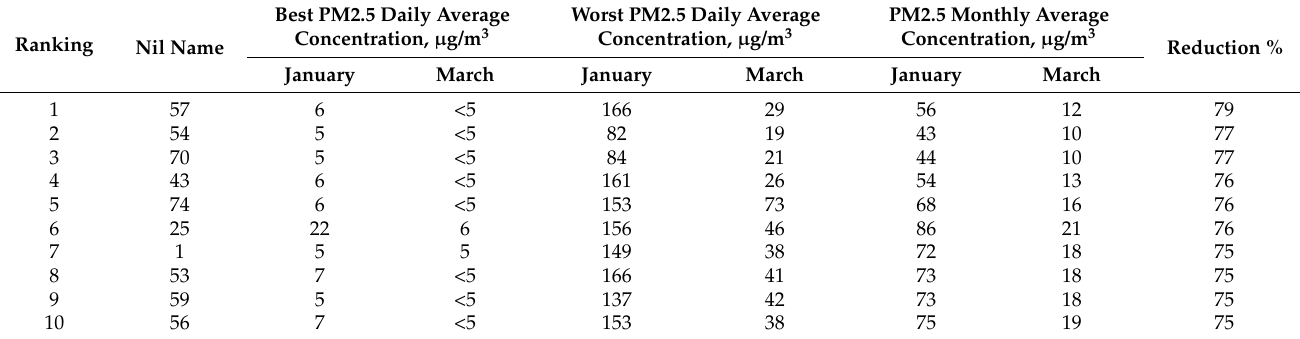
Table 5. Top 10 NILs with the highest PM2.5 reduction rate between March and